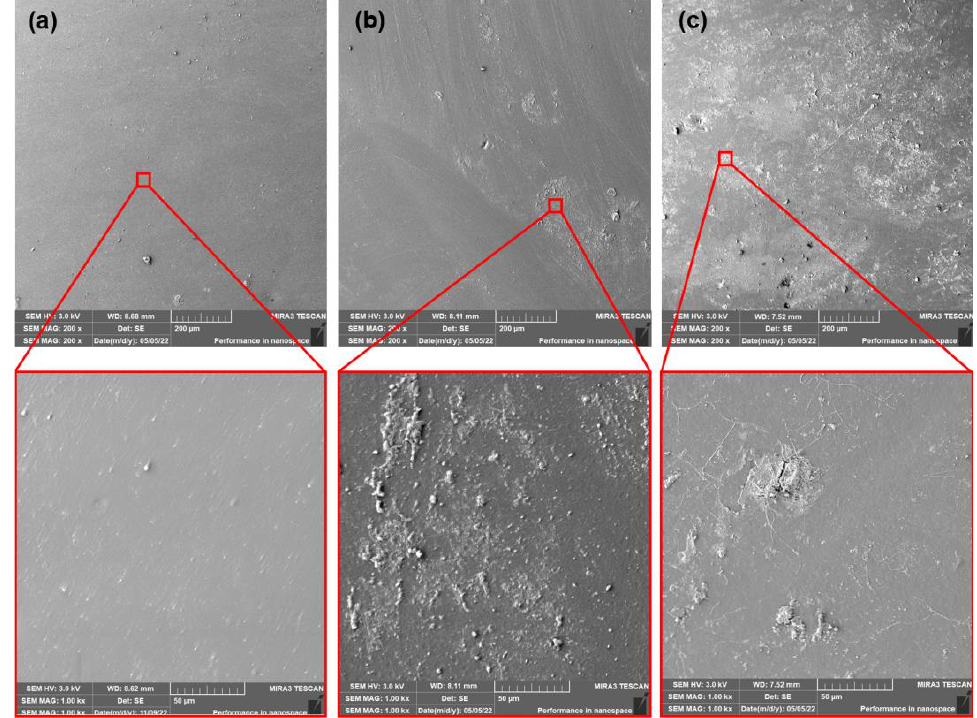
Figure 8. SEM images of as-produced PLA/ATBC films ( a ) at initial state and after ( b ) 14 days of thermophilic composting, and ( c ) 28 days of thermophilic composting.